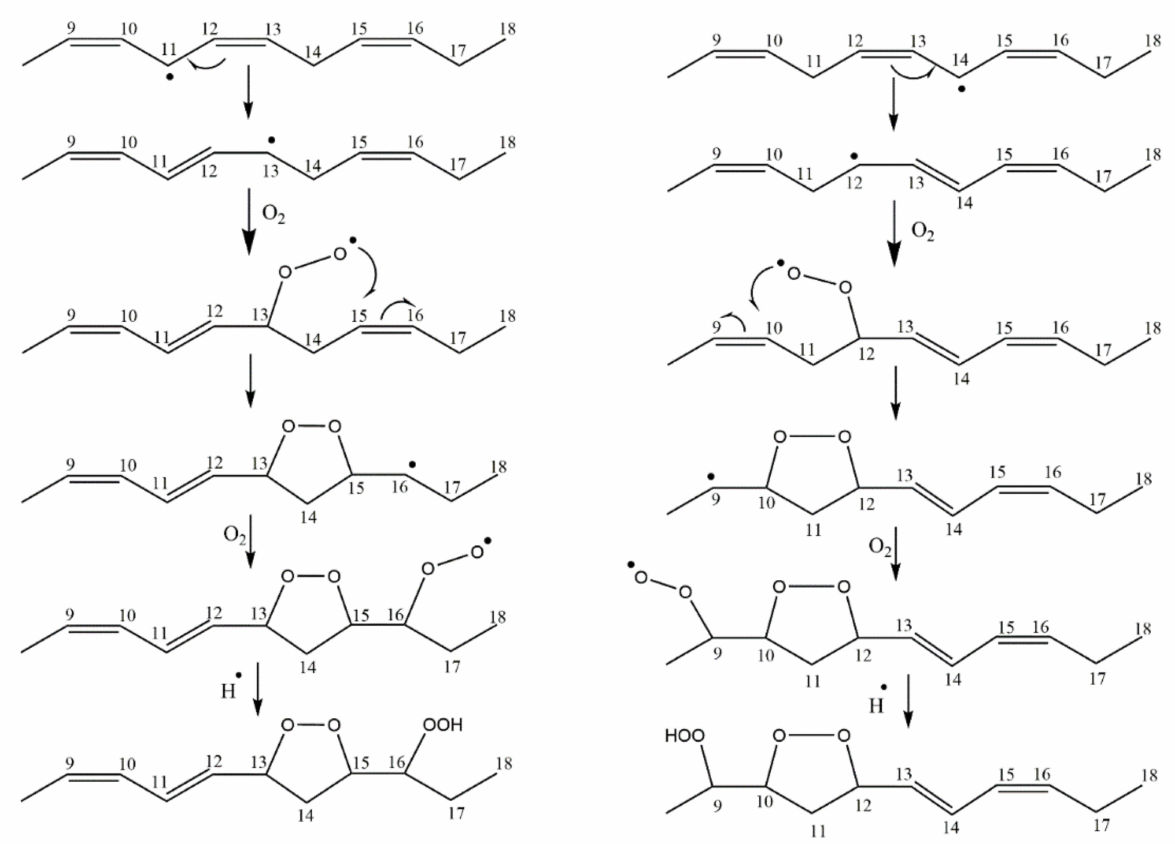
Figure 48. Proposed mechanism of the formation of two diastereomeric pairs of 9- cis , 11- trans -16- OOH, and 13- trans , 15- cis -9-OOH linolenate endo -hydroperoxides